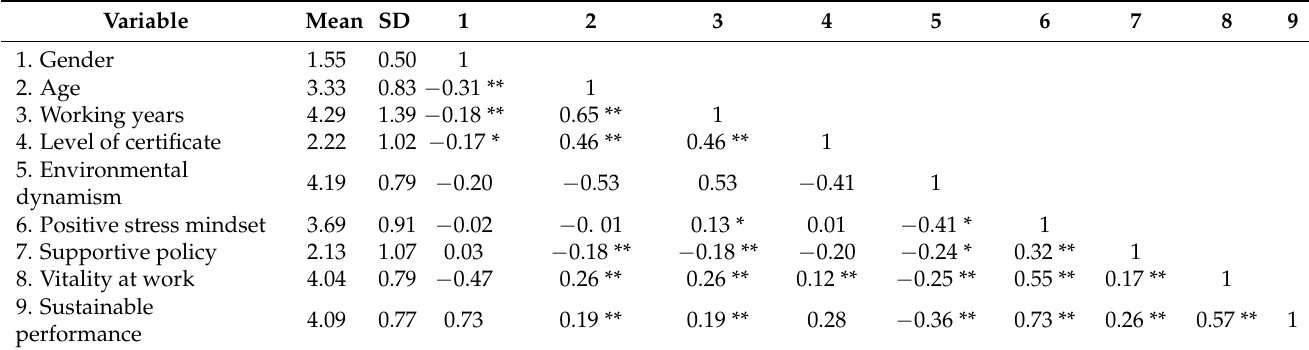
Table 1. Means, standard deviations and correlations.